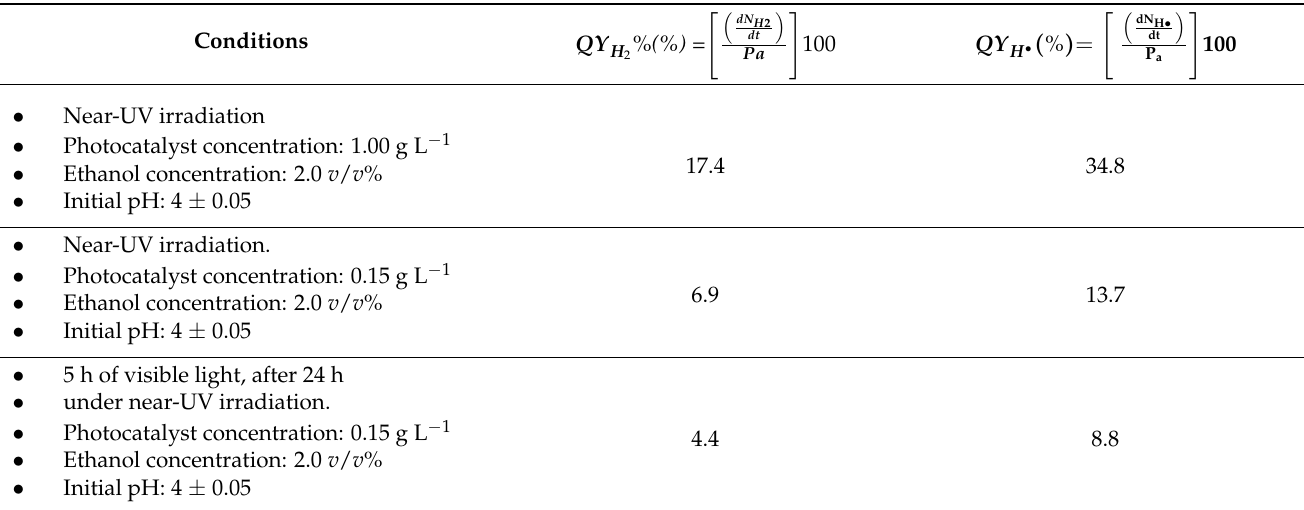
Table 5. Quantum Yields Using a 0.25%wt Pd-TiO 2 Photocatalyst Based on moles of H 2 and H • at different